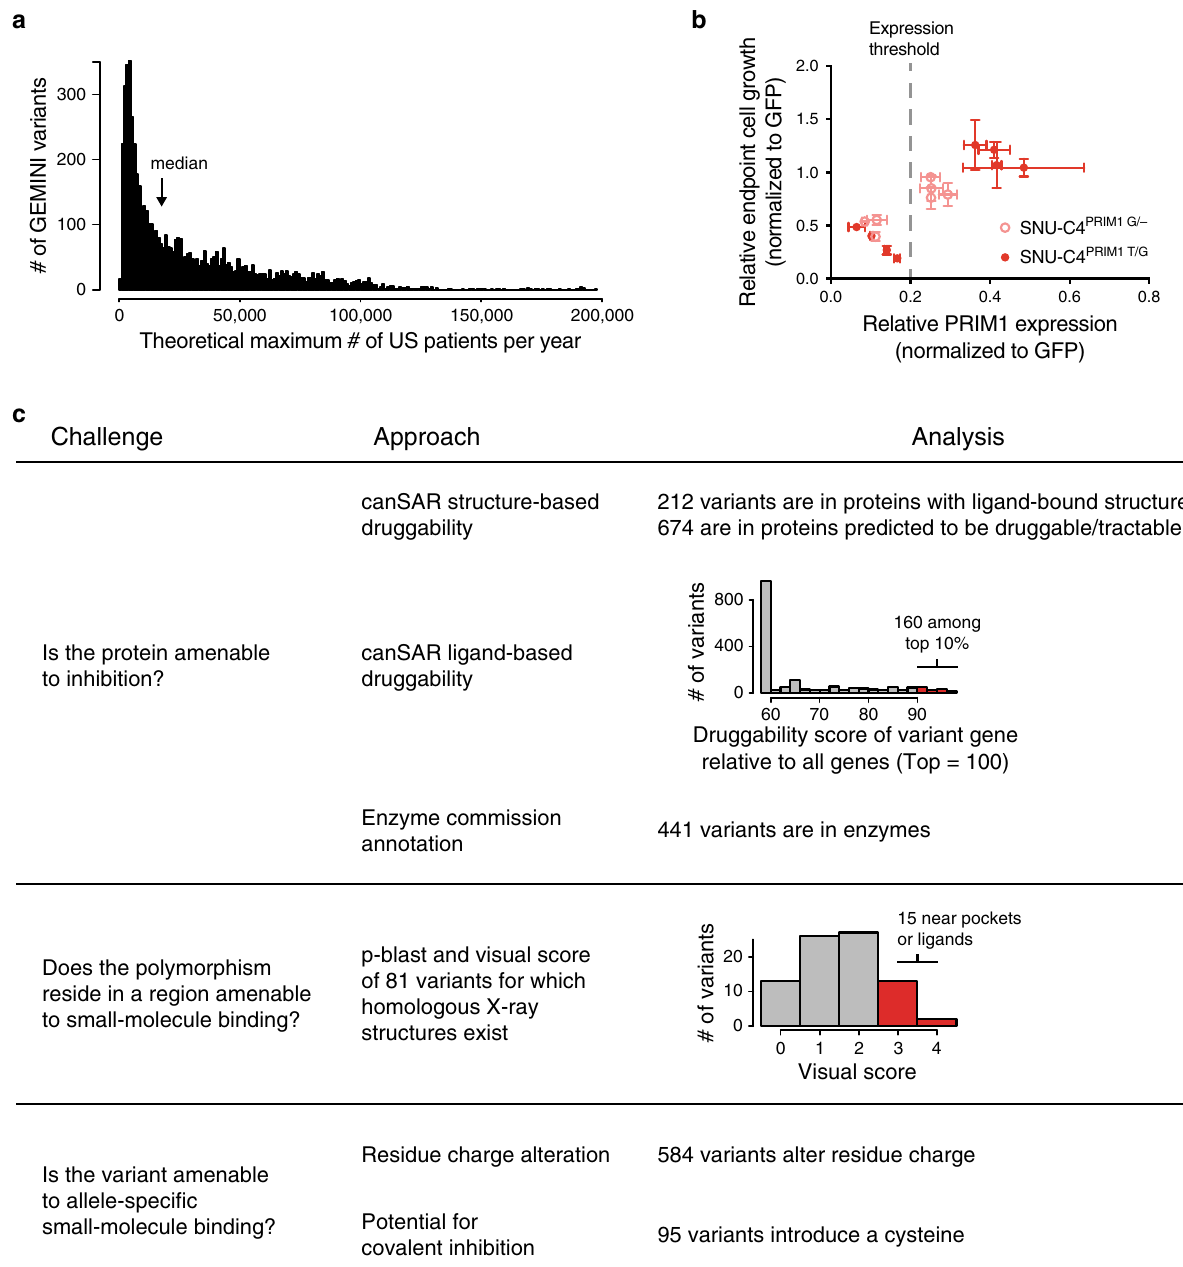
Fig. 4 Potential therapeutic approaches to targeting GEMINI vulnerabilities. a Number of GEMINI variants (vertical axis) plotted against the number of patients per year in the US whose tumors might respond to therapeutics targeting those variants (i.e., have lost the resistant allele from a heterozygous germline; horizontal axis). Bin width = 1000 patients. b Growth of heterozygous (red circles) and hemizygous cells (pink circles) expressing positive control, non-allele speci fi c PRIM1 -targeting shRNAs versus PRIM1 mRNA expression. Cell growth measured by CellTiter-Glo luminescence relative to day 2 post-infection and shGFP ( n = 5 technical replicates). PRIM1 mRNA expression assessed by qRT-PCR ( n = 3 technical replicates). Data are presented as mean values ± s.d. Dashed gray line indicates PRIM1 expression threshold below which substantial decreases in cell viability are observed. c Summary table representing challenges to developing allele-speci fi c small molecules that target GEMINI vulnerabilities and associated analyses to prioritize targets. Source data for Fig. 4b is provided as a Source Data fi